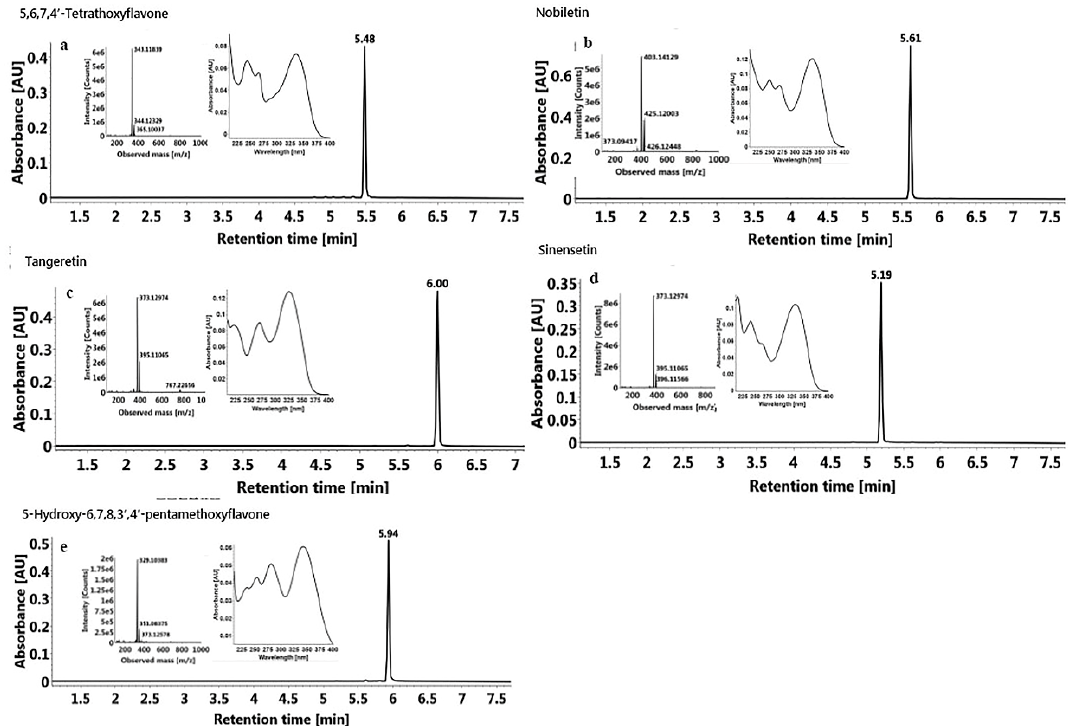
Figure 7. UPLC chromatograms, UV, and MS spectrums of five PMFs isolated by prep-HPLC. Compound 1 (Figure 7a, 94.8 mg) was a yellow powder: ESI-MS m / z 343. 33839 [M + H] + , C 19 H 18 O 6 . 1 H NMR (400 MHz, CDCl 3 ) δ 7.93–7.85 (m, 2H), 7.06–6.97 (m, 2H), 6.60 (s, 1H), 6.44 (s, 1H), 4.01 (s,